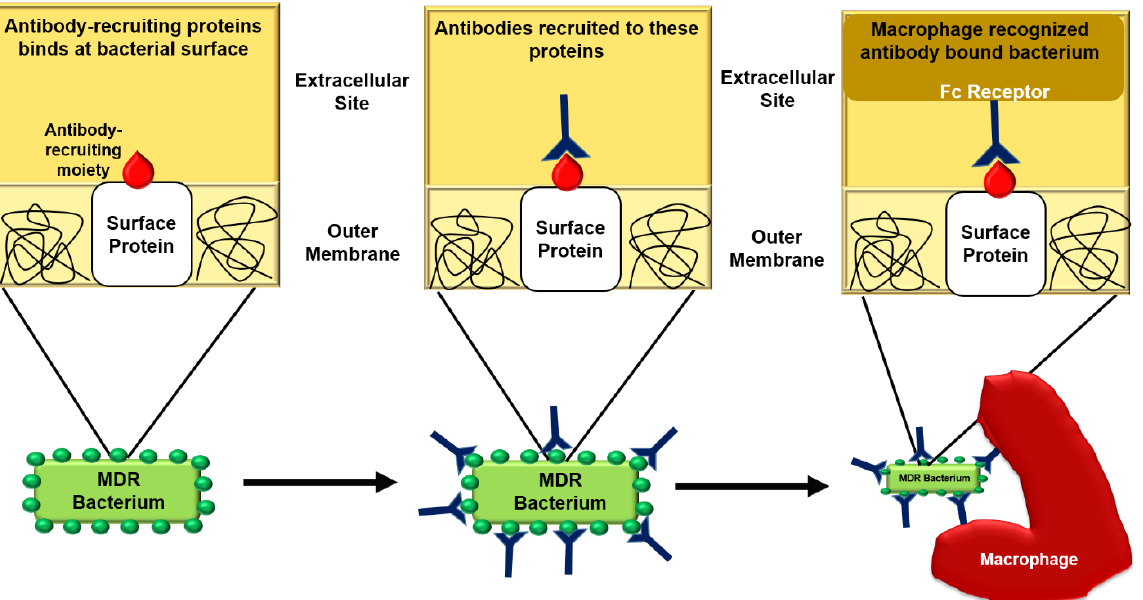
Figure 8. Mode of action of novel antibodies how they bind to multidrug-resistant (MDR) bacteria and present to macrophages and destroy them.